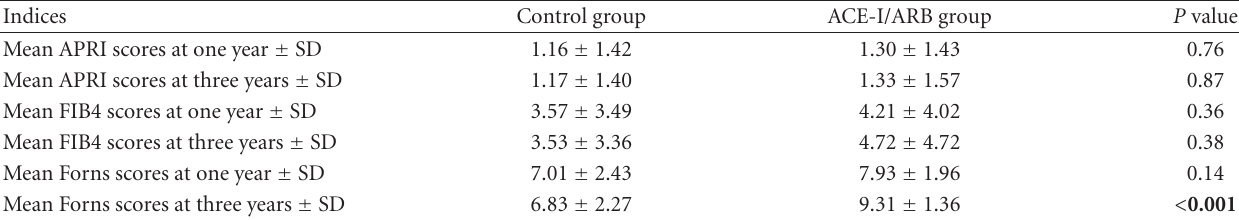
Table 4: Number of subjects from each group with scores predictive of significant fibrosis at one year and three years (univariate analysis). Indices